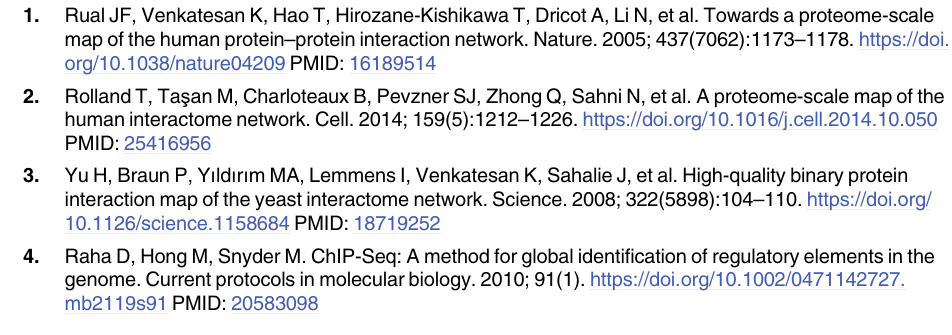
S4 Table. Median edge rankings and average edge prevalence scores over five computations for Fig 3C. S5 Table. Median edge rankings and average edge prevalence scores over five computations for Fig 3D. S6 Table. Yeast cell cycle results for edge finding. S7 Table. Yeast cell cycle results for network